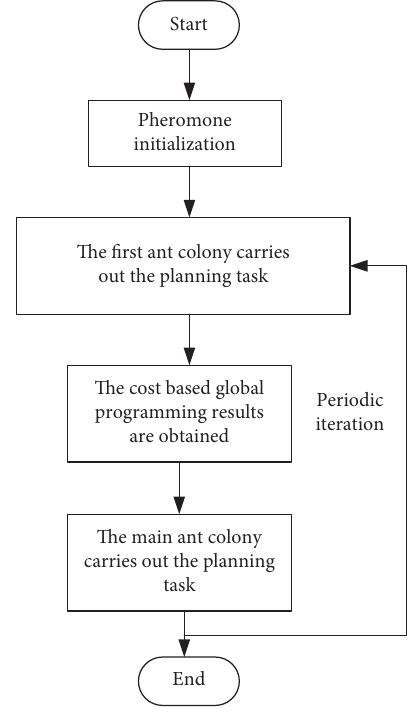
Figure 2: Algorithm